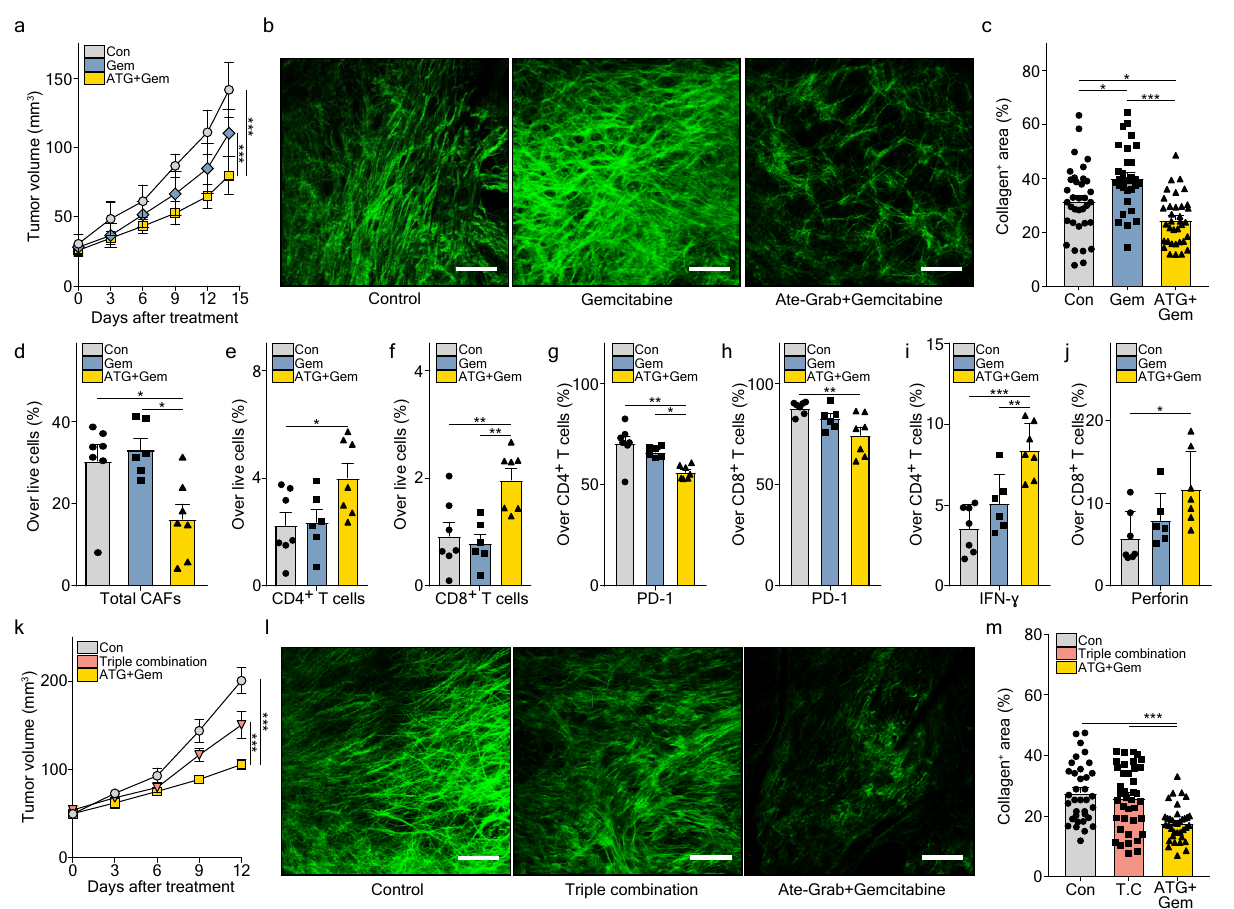
Fig. 5 | Ate-Grab acts in synergy with the antitumor effects of gemcitabine, unlike the triple combination of atezolizumab, VEGF-Grab, and gemcitabine. a – j When tumor volume reached 50 – 100 mm 3 , tumor-bearing mice were intra- peritoneallytreatedwitheitherPBS(Con; n =7),gemcitabine(Gem; n =6),andAte- Grab+gemcitabine(ATG+Gem; n =7)(50mg/kgforgemcitabine,10mg/kgforAte- Grab,every3days). a Tumorvolumesofdrug(indicated)-treatedmice.*** P <0.001; two-wayANOVA with Tukey ’ s multiplecomparisons. b Representative SHG images ofPan02tumors,onday24aftertumorinoculation.Greensignalsindicatecollagen distribution.Scalebars,100 μ m. c Averagepercentagesofcollagen + areaintumors of each group. Data from randomly selected fi elds of view were analyzed (Con, n =35; Gem, n =30; ATG+Gem, n =35). * P <0.05 (Con vs Gem: P =0.011, Con vs ATG+Gem: P =0.030), *** P <0.001. one-way ANOVA with Tukey ’ s multiple com- parisons. Average percentages of d total CAFs (Con vs ATG+Gem: P =0.024, Gem vs ATG+Gem: P =0.010), e CD4 + T cells ( P =0.048) and f CD8 + T cells (Con vs ATG+Gem: P =0.007, Gem vs ATG+Gem: P =0.04) over total live cells in Pan02 tumors from each treatment group, measured by fl ow cytometry. * P <0.05,